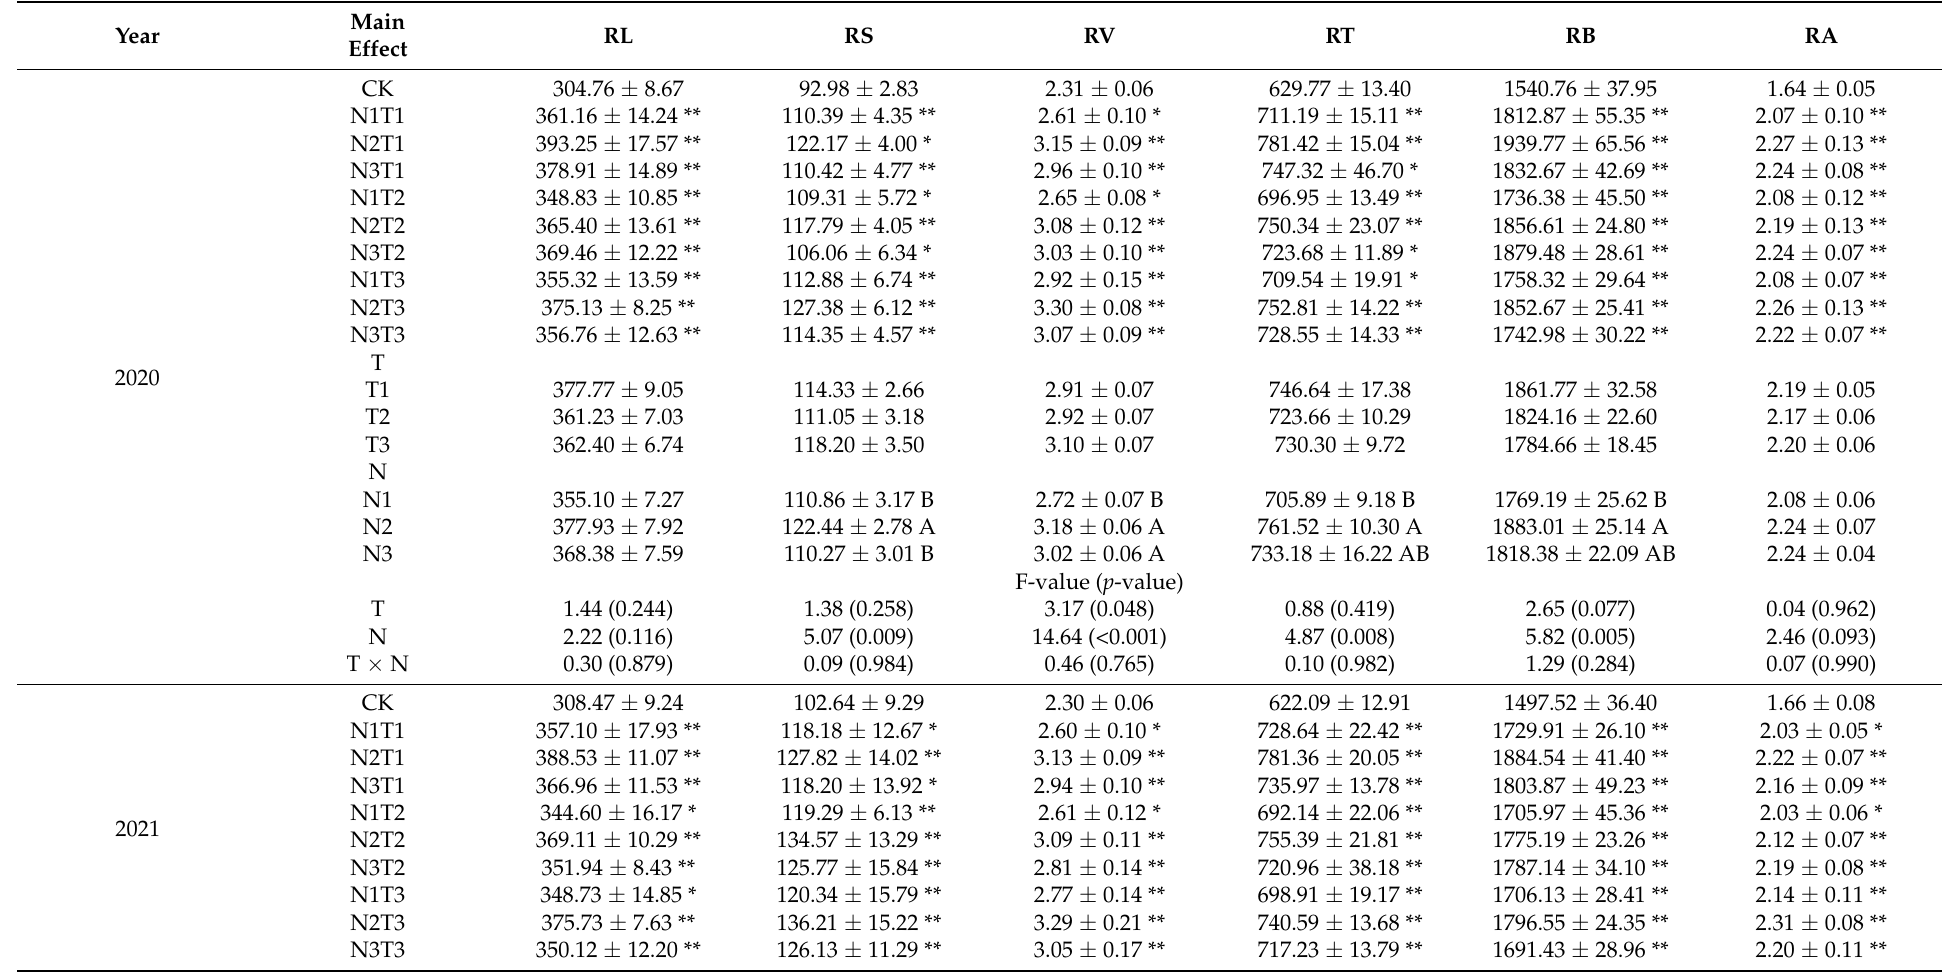
Table 3. Response of tomato total root length (RL, cm · plant − 1 ), total surface area (RS, cm 2 · plant − 1 ), total root volume (RV, cm 3 · plant − 1 ), total number of root